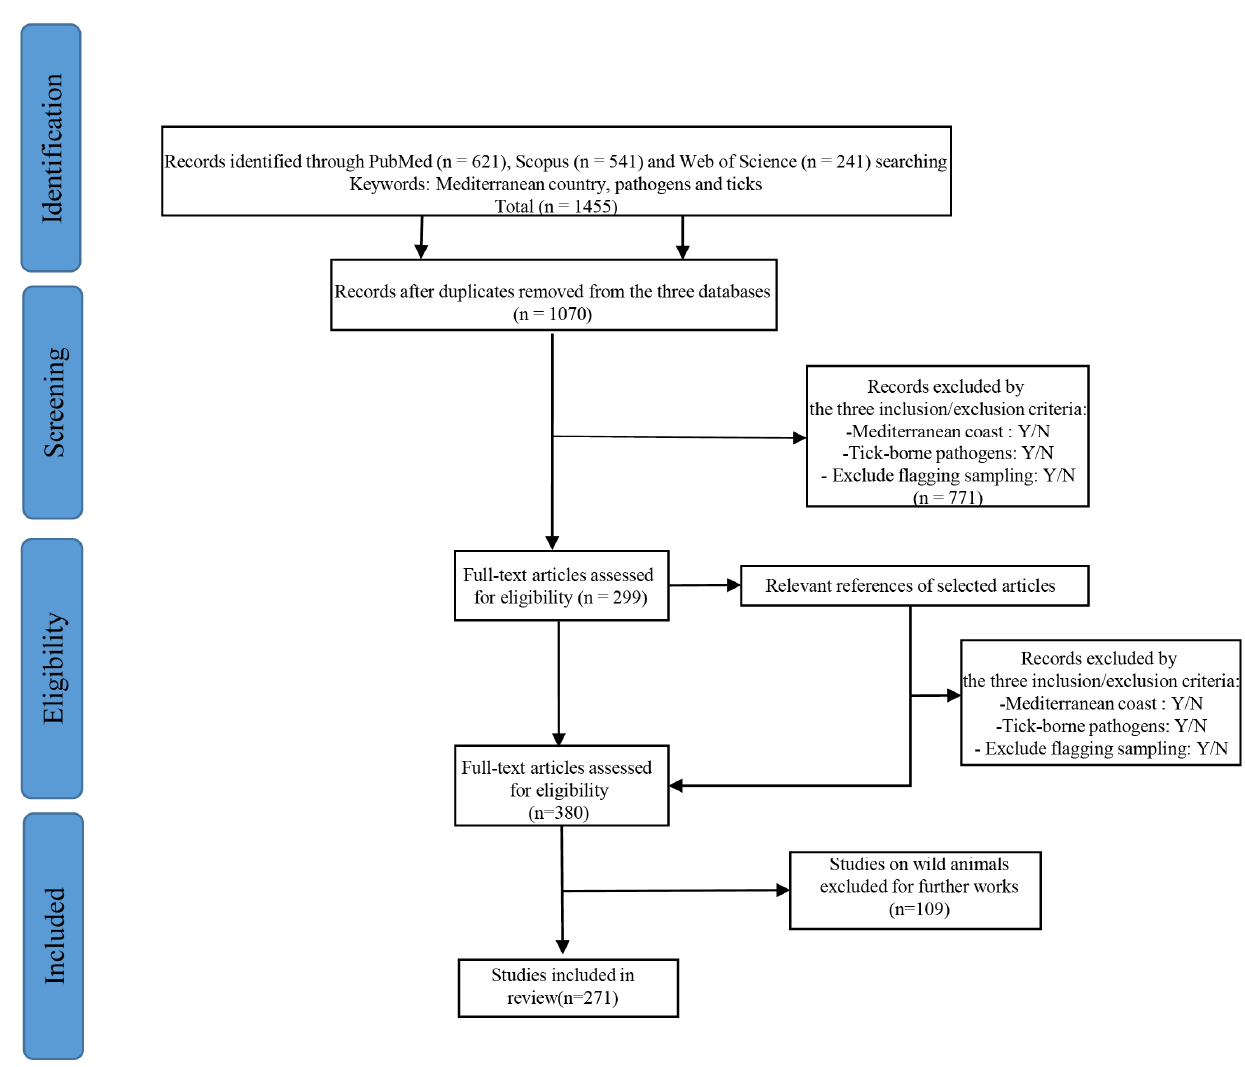
Figure 1. Methodological diagram of the bibliographic research following the PRISMA 2009 Flow according to Moher et al., 2015 [21].